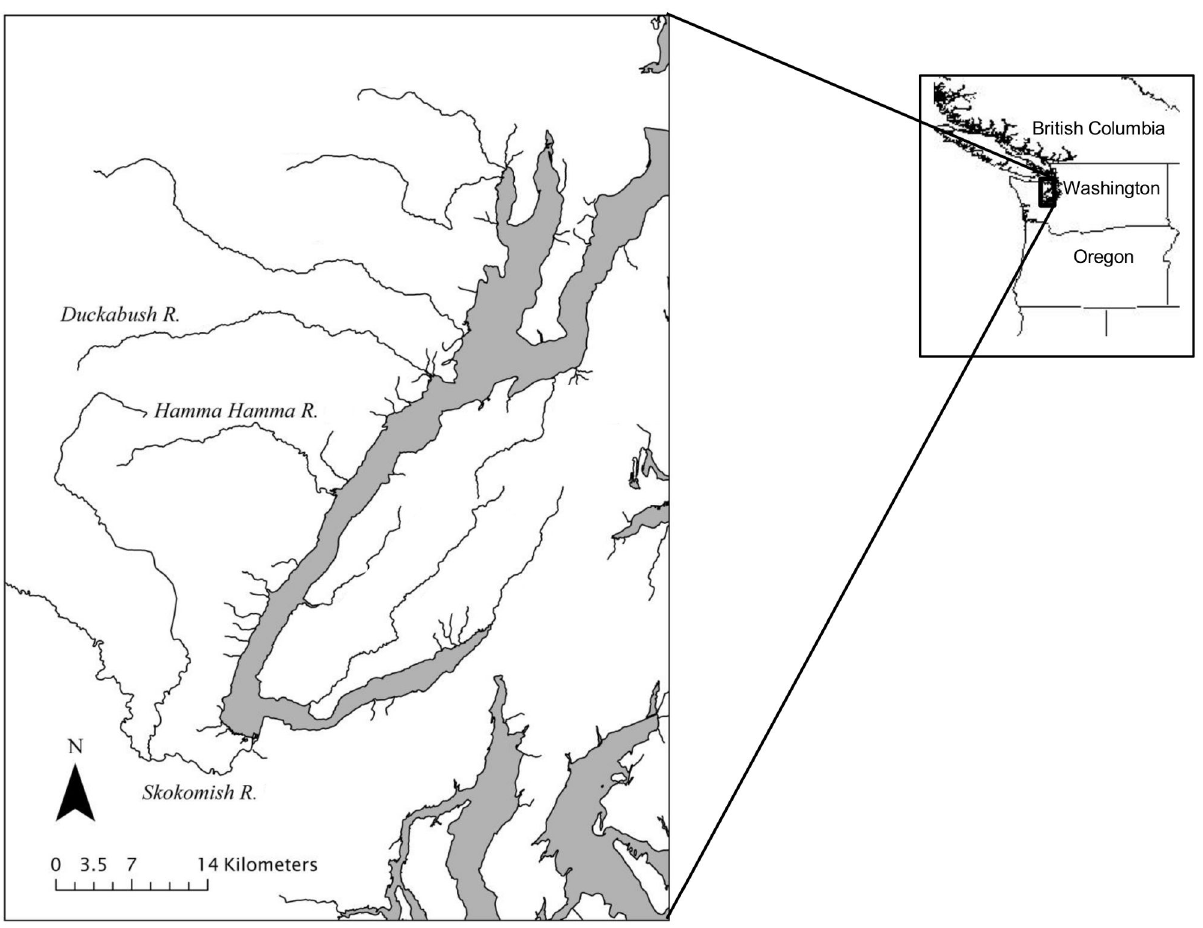
Figure 1. Map of the study area. The three rivers where O. mykiss samples were